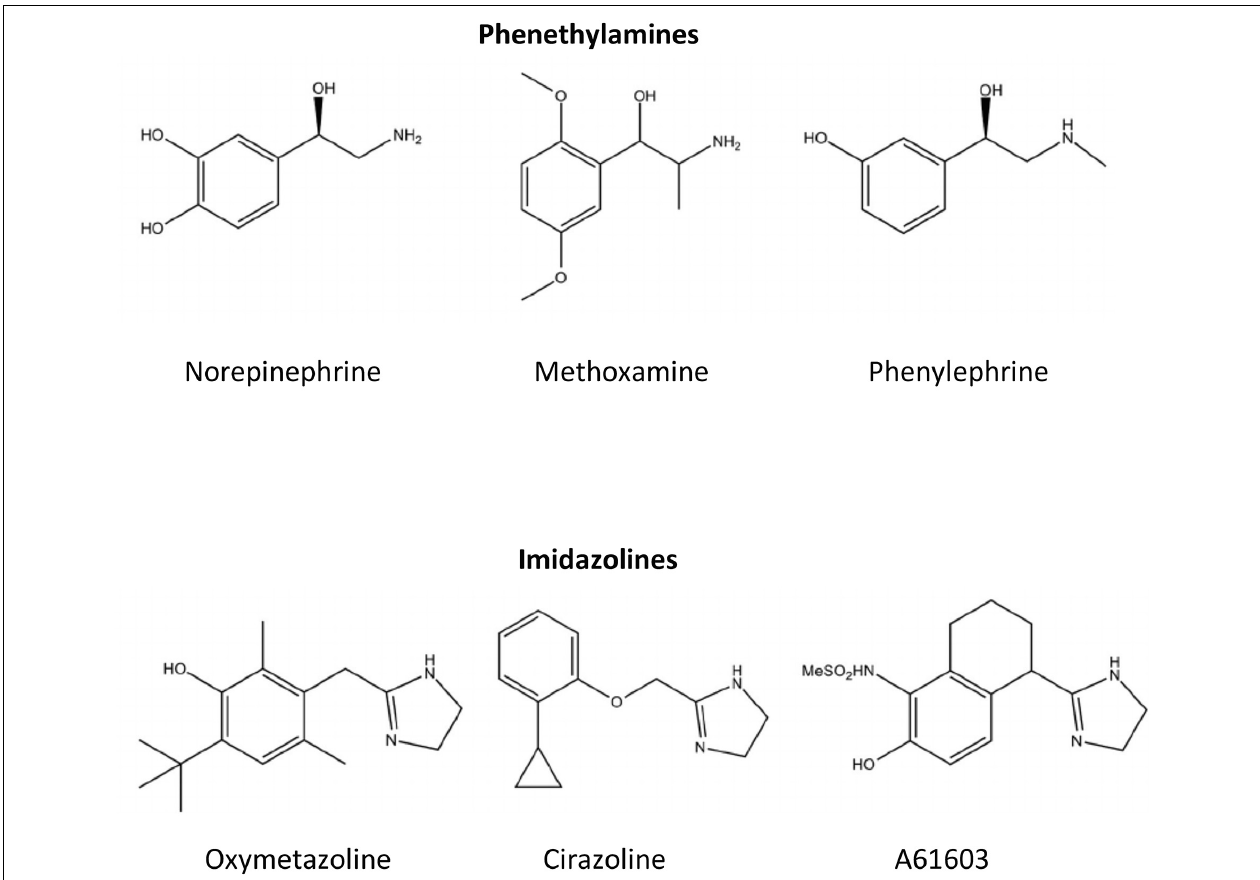
FIGURE 1 | Chemical structures for common α 1 -AR agonists. Ligands such as norepinephrine that contain a phenyl, two-carbon ethyl, and amine group in their structural backbone are referred to as phenethylamines. Ligands that contain an imidazole ring in its structural backbone instead of the phenyl ring are referred to as